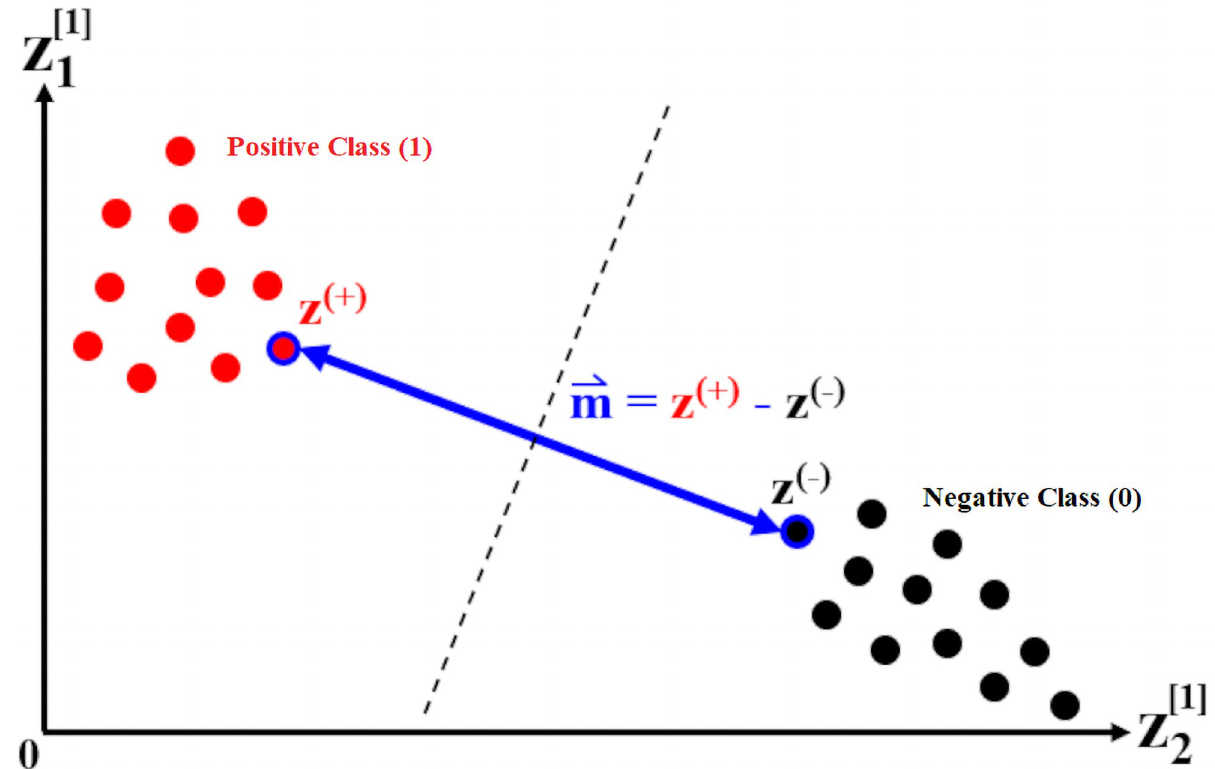
Fig 9. Feature selection based on direction of optimal